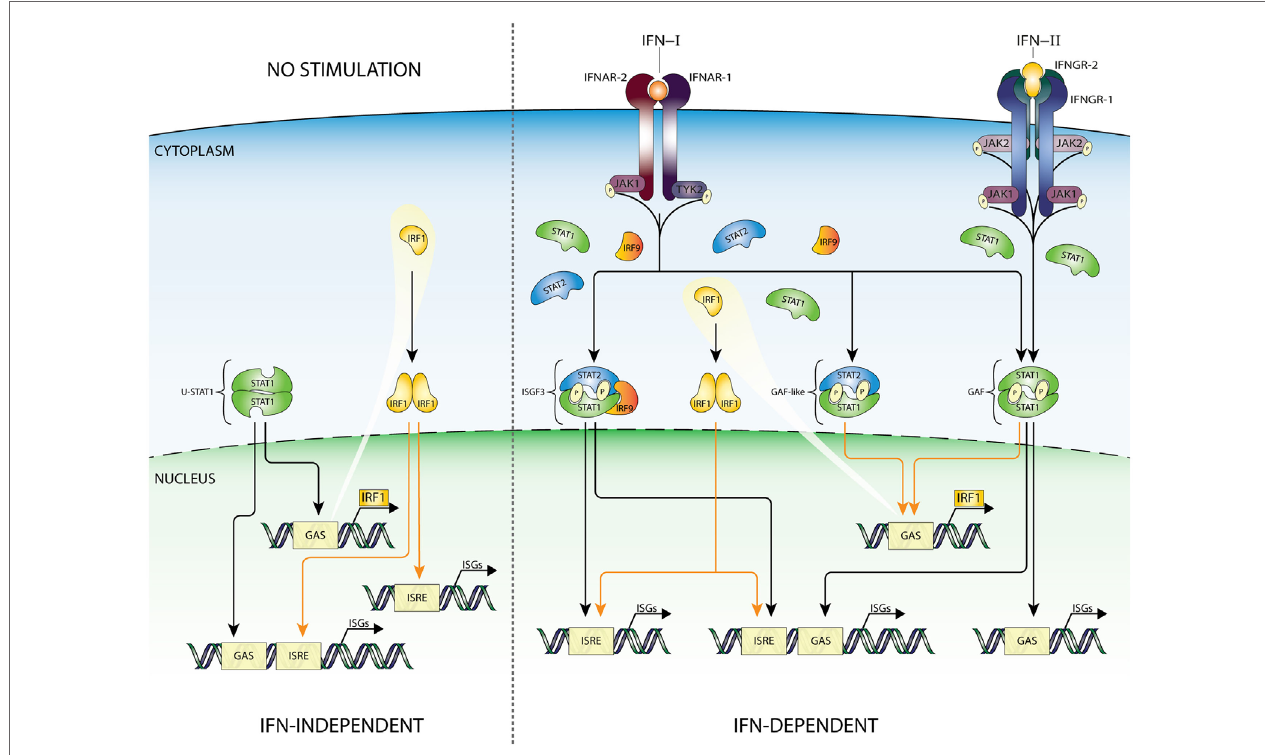
FiGUre 3 | IFN-dependent and -independent ISG transcription mediated by IRF1. According to the current state of knowledge, expression of IRF1 is driven by homodimers of STAT1 (GAF), as well as STAT1/STAT2 heterodimers, recognizing a single GAS sequence in the IRF1 promoter. Recent studies confirmed that basal expression of IRF1 can be detected in many cell types under basal conditions. Moreover, binding of IRF1 to ISRE-containing genes can play a role in maintaining constitutive expression of certain group of ISGs (left panel). After IFN-I or IFN-II stimulation GAF and GAF-like (STAT1/STAT2 heterodimers) complexes are rapidly formed and translocated to the nucleus to initiate IRF1 expression. Subsequently, IRF1 as an additional abundant transcription factor can collaborate with ISGF3 and GAF complexes stimulating ISRE-containing genes, thus appearing as an important link between IFN-I and IFN-II responses. Abbreviations: IFN, interferon; STAT, signal transducer and activator of transcription; IRF, interferon regulatory factor; JAK, Janus kinase; TYK, tyrosine kinase; ISGF3, interferon-stimulated gene factor 3; GAF, γ -activated factor; ISRE, interferon-stimulated response element; GAS, γ -activated sequence; ISG, interferon-stimulated gene; P,